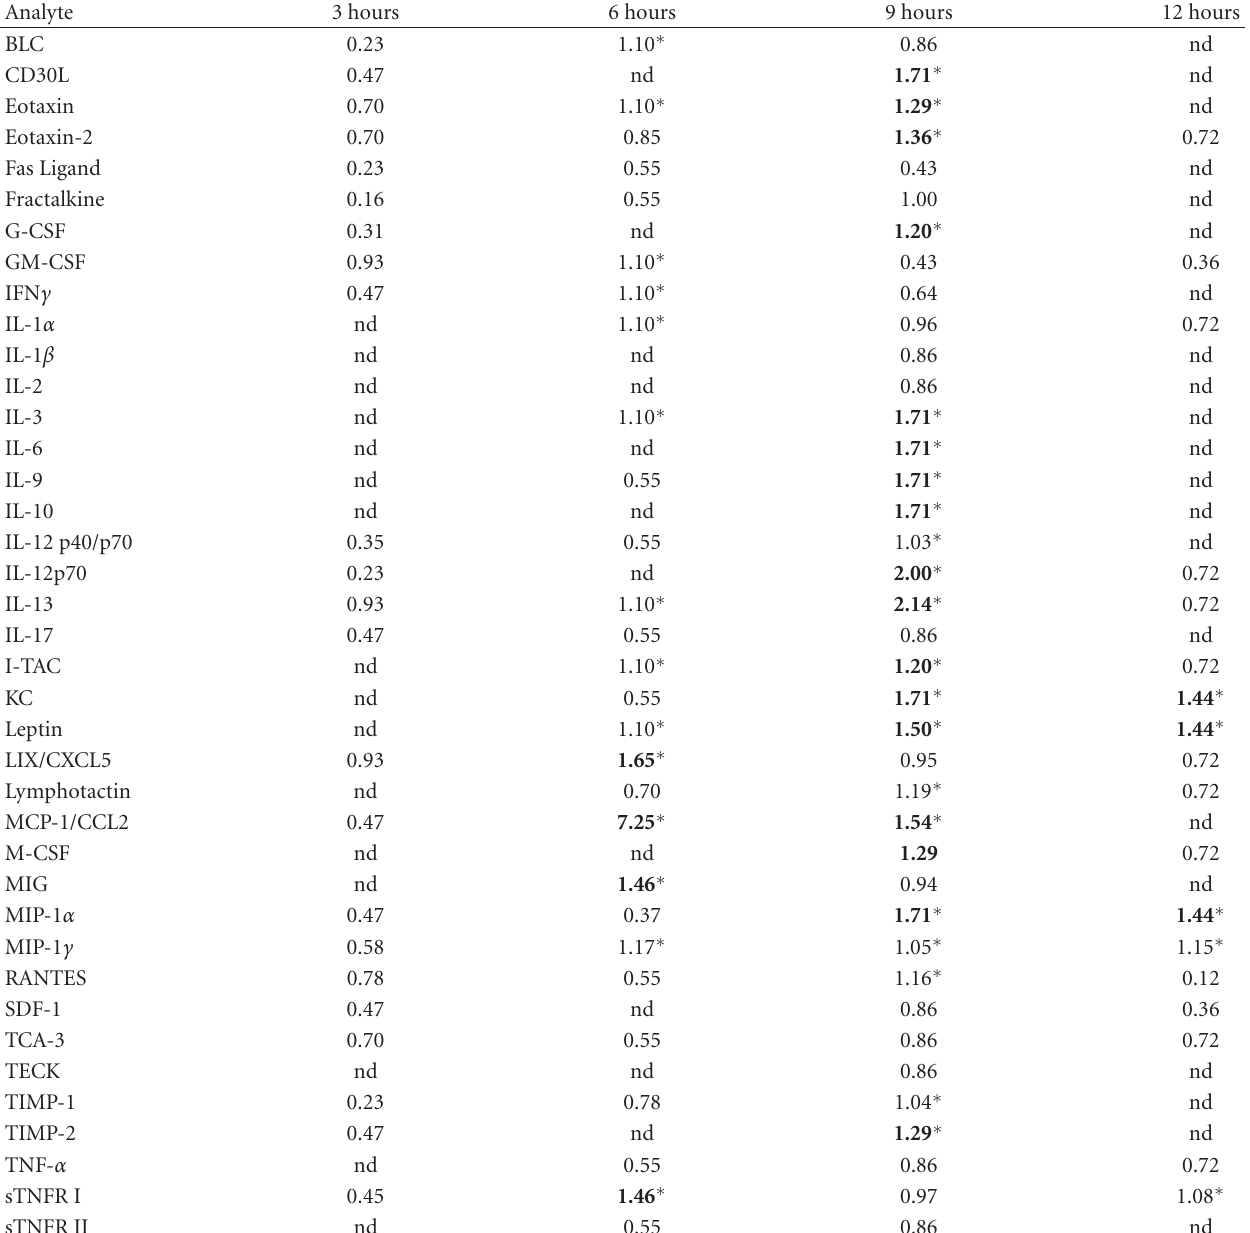
Table 1: Analysis of the di ff erent analytes detected in the cell free exudates harvested from IL-4-induced air pouch 1 .